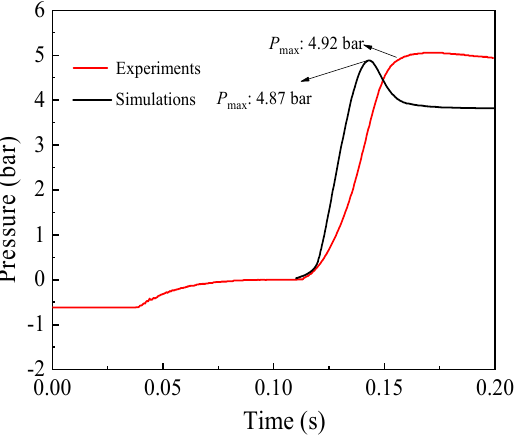
Figure 9. Comparison of experimental data and simulation of explosion for 250 g/m 3 Mg/air mixture.